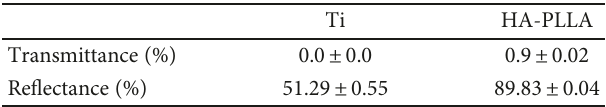
Table 1: Roughness and contact angles (CA) of Ti and HA-PLLA surface.